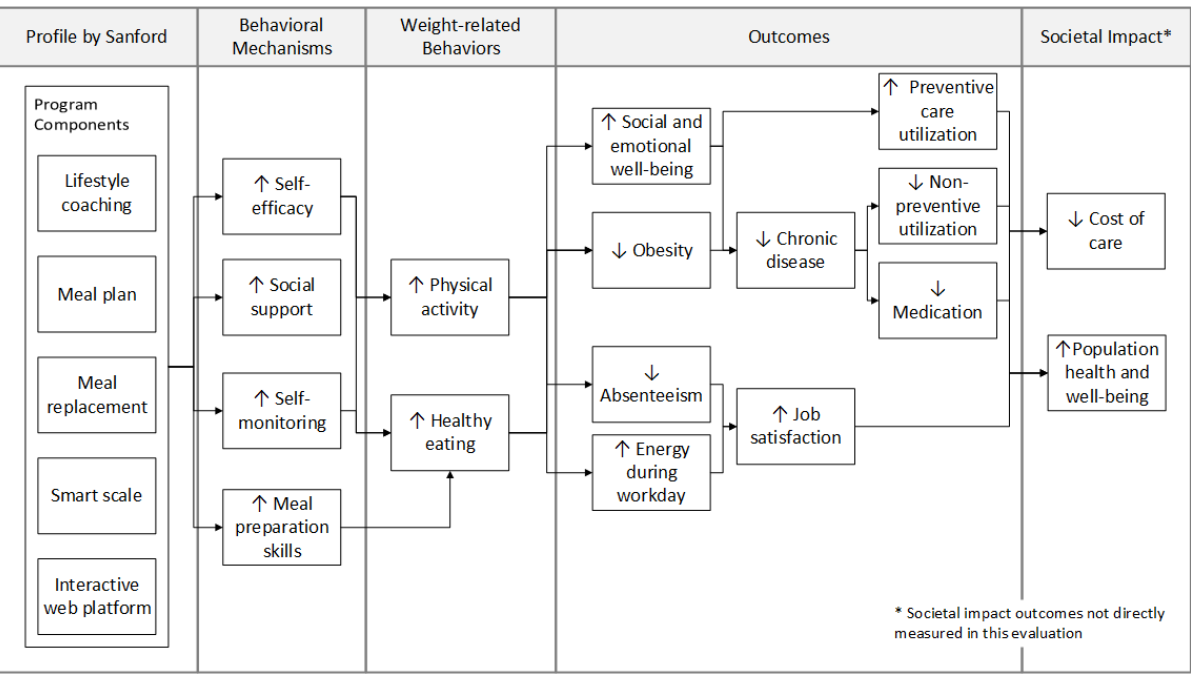
Figure 1. Conceptual model showing the hypothesized pathway from program components to behavioral mechanisms, behaviors and outcome measures in this study.